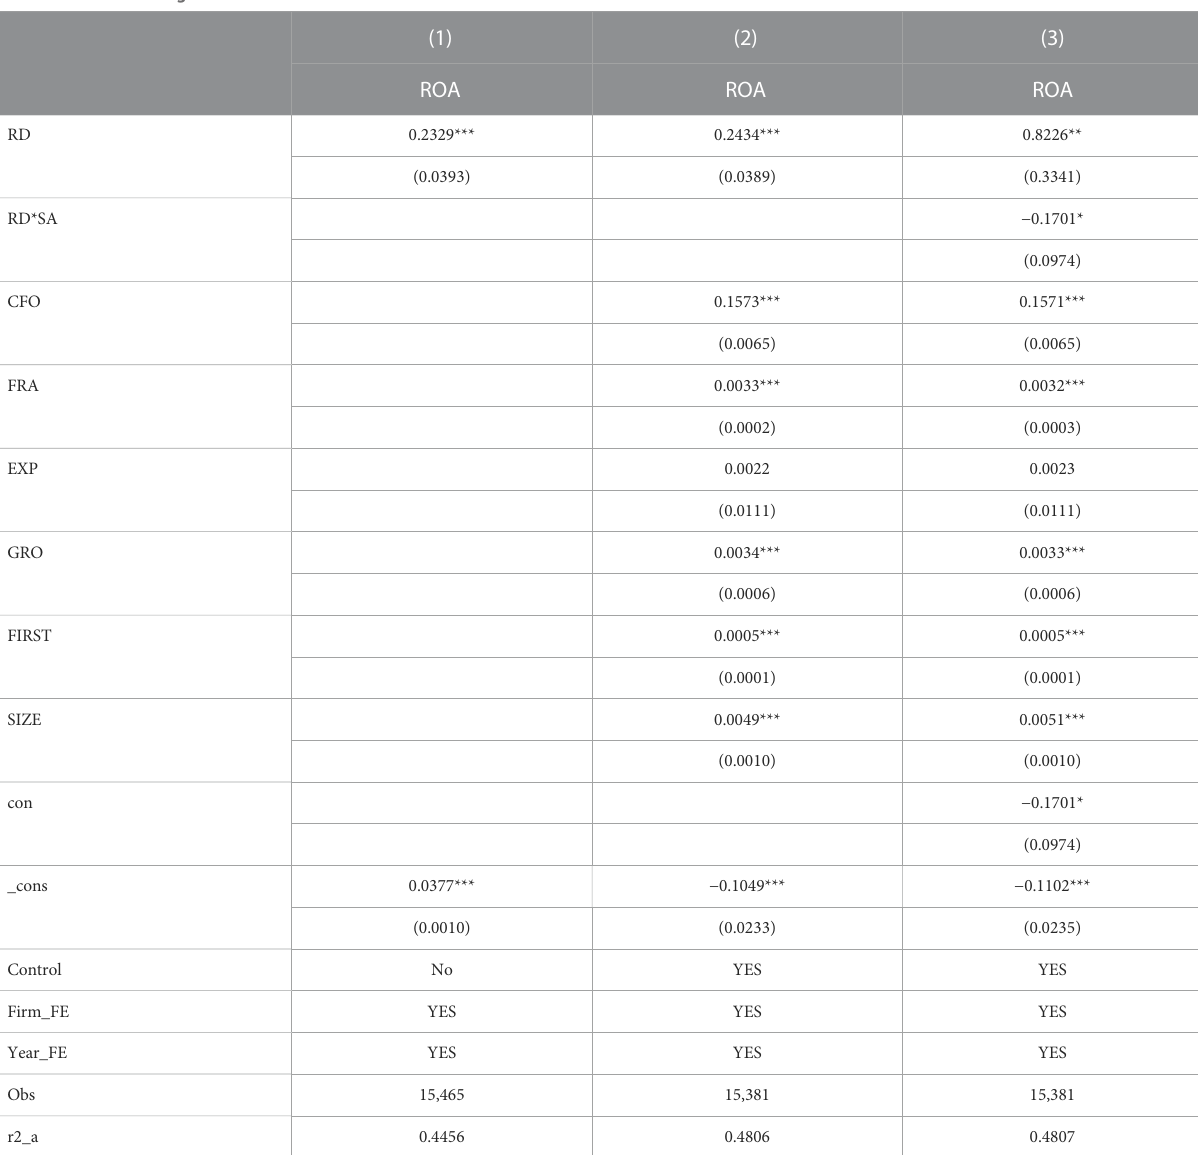
TABLE 3 Benchmark